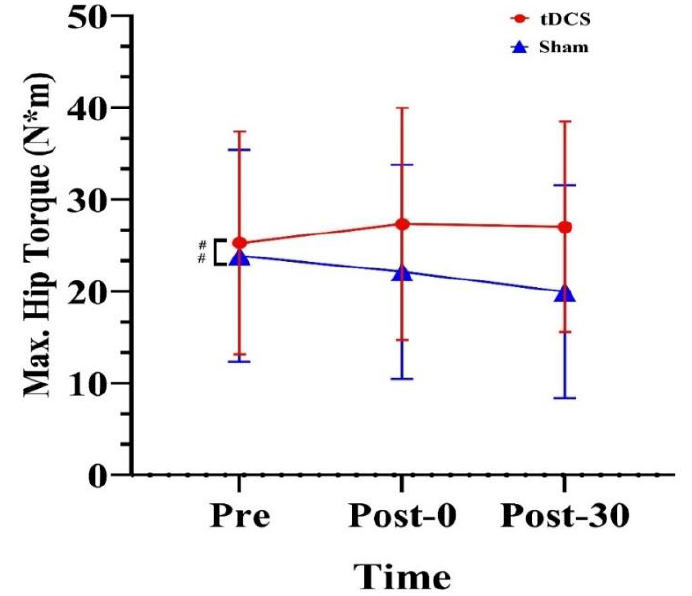
Figure 9. Effects of tDCS on maximum hip torque in CMJs. ## indicates a significant main effect of condition. Max.: maximum, Pre: pre-stimulation, Post-0: post-0 min, Post-30: post-30 min.